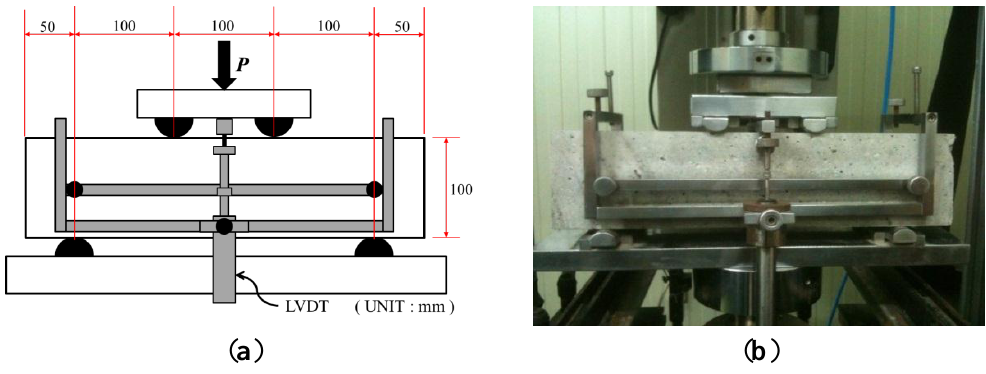
Figure 6. Bending specimen geometry and test set-up. ( a ) Specimen geometry; ( b ) Test set-up picture.